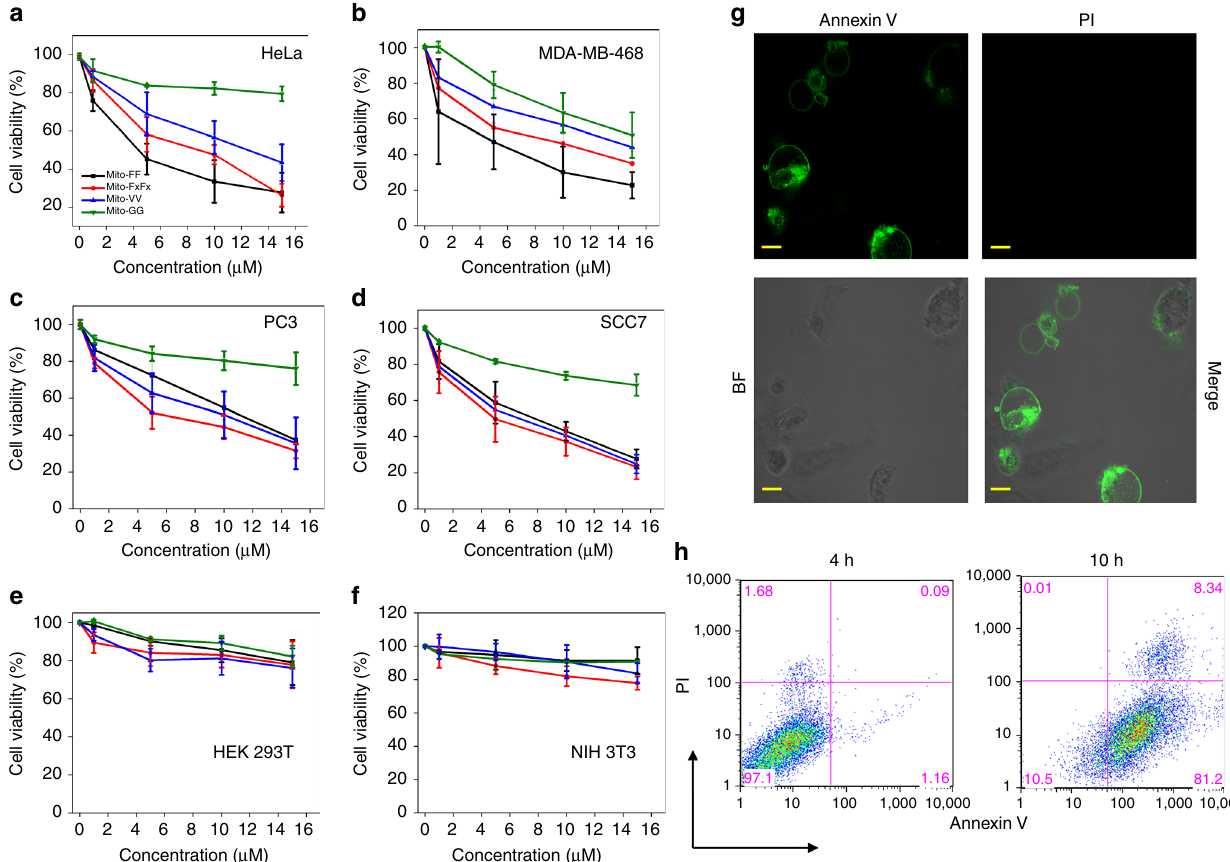
Fig. 6 Intra-mitochondrial assembly for cancer therapy. a – d Analysis of Mito-FF toxicity in different cancer cell lines. Data represent mean ± s.d. from three independent experiments. e – f Analysis of Mito-peptide toxicity in normal cell lines. g Cell death induced by Mito-FF was monitored by Annexin V/PI staining, which showed early apoptosis (scale bar, 10 μ m). h Flow cytometric analysis showing early apoptosis induced by